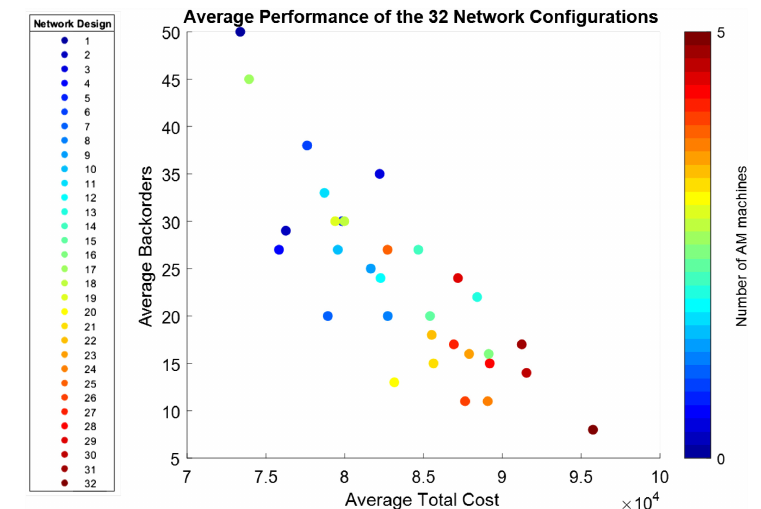
Figure 7. (Color online) Performance results from Monte Carlo simulation. Results condensed by averaging the backorders and total cost. Each network configuration is represented by a single point on the